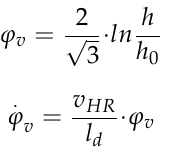
Table 2. Parameters for the hot rolling of the twin-roll cast and homogenized WZ73. Parameter of Hot